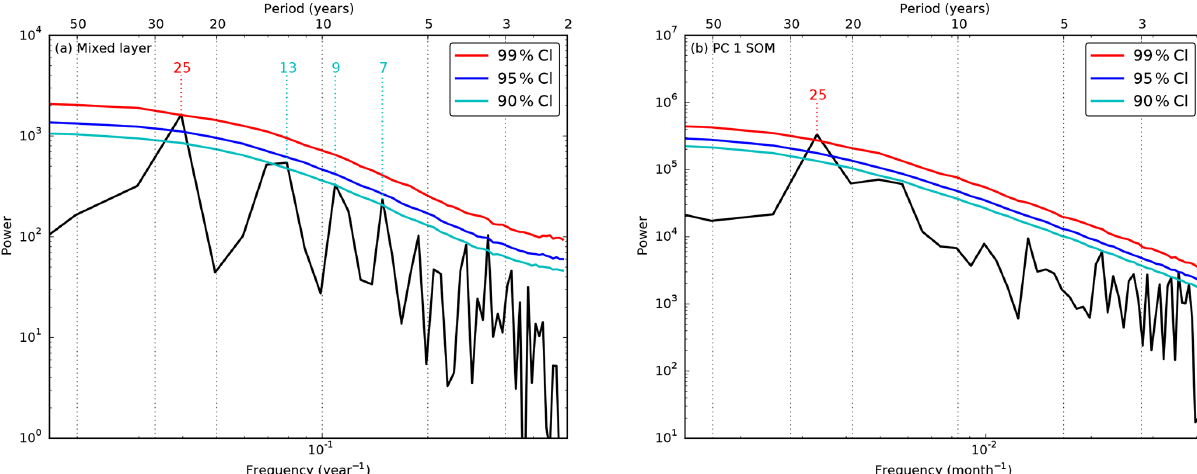
Figure 5. Fourier spectrum of the (a) mixed layer depth averaged over the polynya region and (b) the SOM. Before determining the spectrum, the yearly mixed layer depth time series is normalised (to the SD). For the SOM, we retained the non-smoothed first PC time series (see Sect. 3). The confidence intervals (CIs) of significance (99% (red), 95% (blue) and 90% (cyan)) are derived from 10000 surrogate time series. The indicated periods (in years) are significant at the corresponding colour-coded confidence interval, while only indicating low frequencies ( ≥ 5